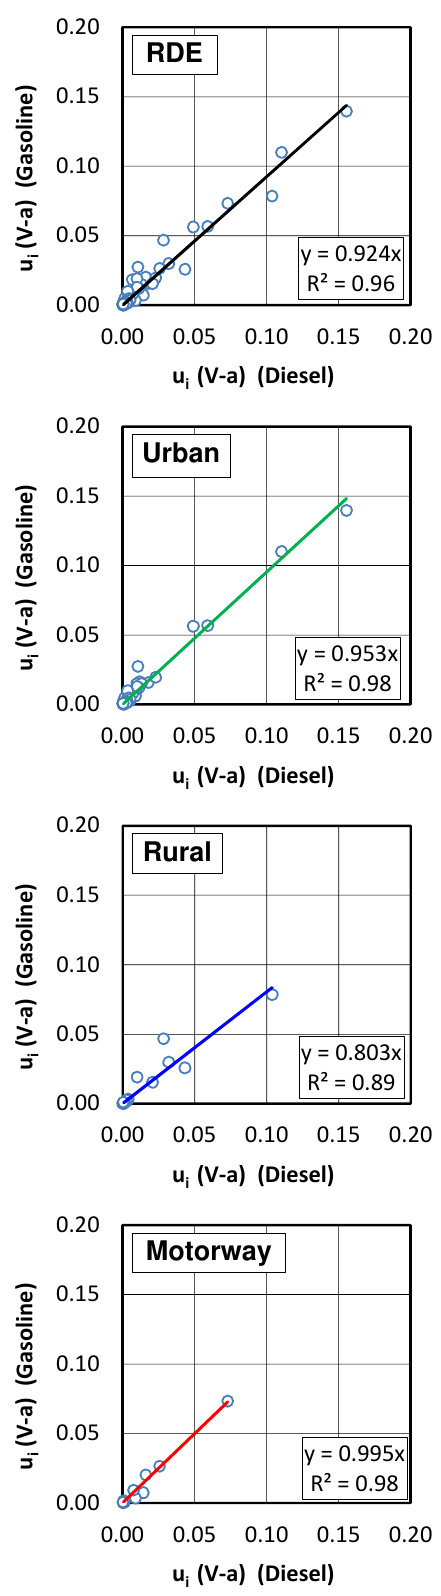
Fig. 6. Comparison of the test drives compliance (vehicles with gasoline engine and diesel engine) with the use of linear correlation of vehicle operating time share in each velocity and acceleration